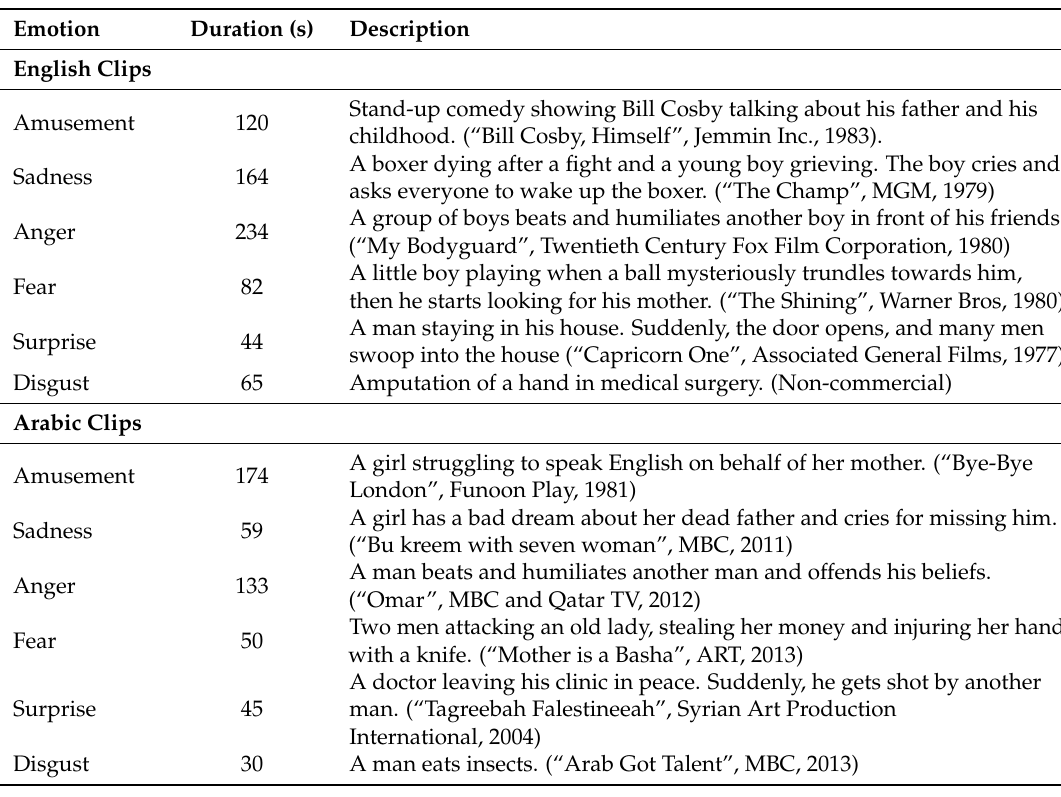
Table 1. Description of English and Arabic video clips used as